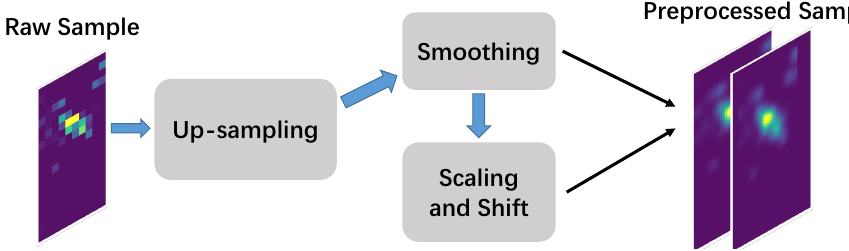
Figure 3. The preprocessing workflow. The number of pressure images is